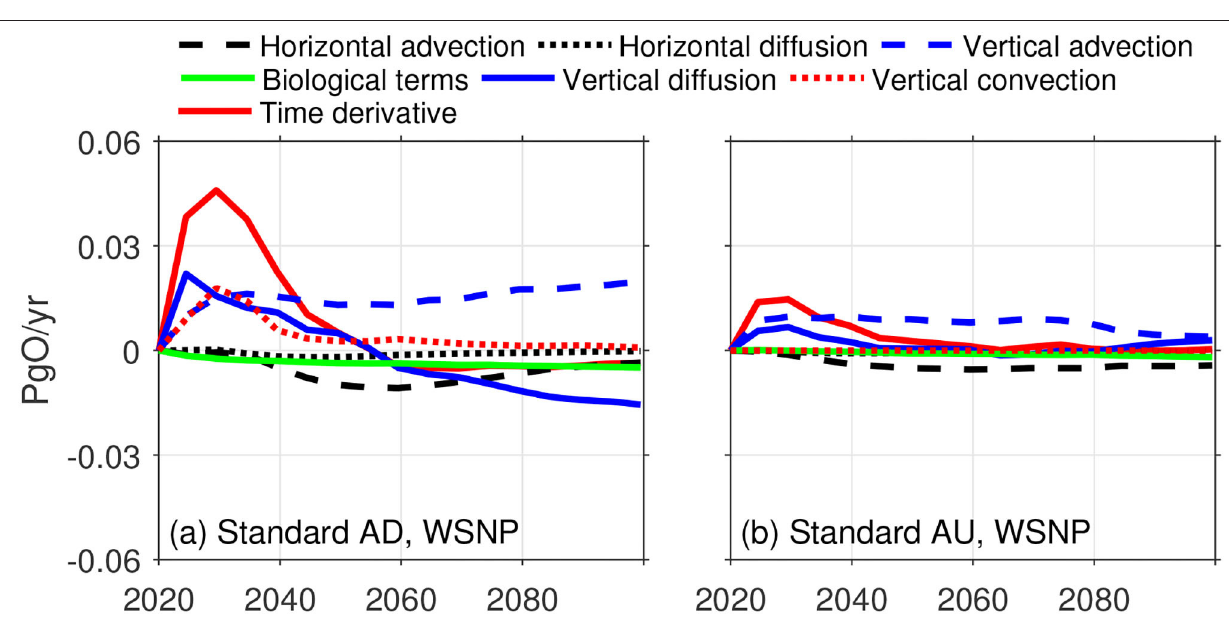
FIGURE 5 | Time series of (a) AD and (b) AU-induced anomalies, relative to the reference run, of oxygen budget terms integrated within the WSNP at the fifth model layer (i.e., 380–550 m highlighted in Figure 4 ). Note that vertical advection terms here and in the main text include direct and indirect pumping